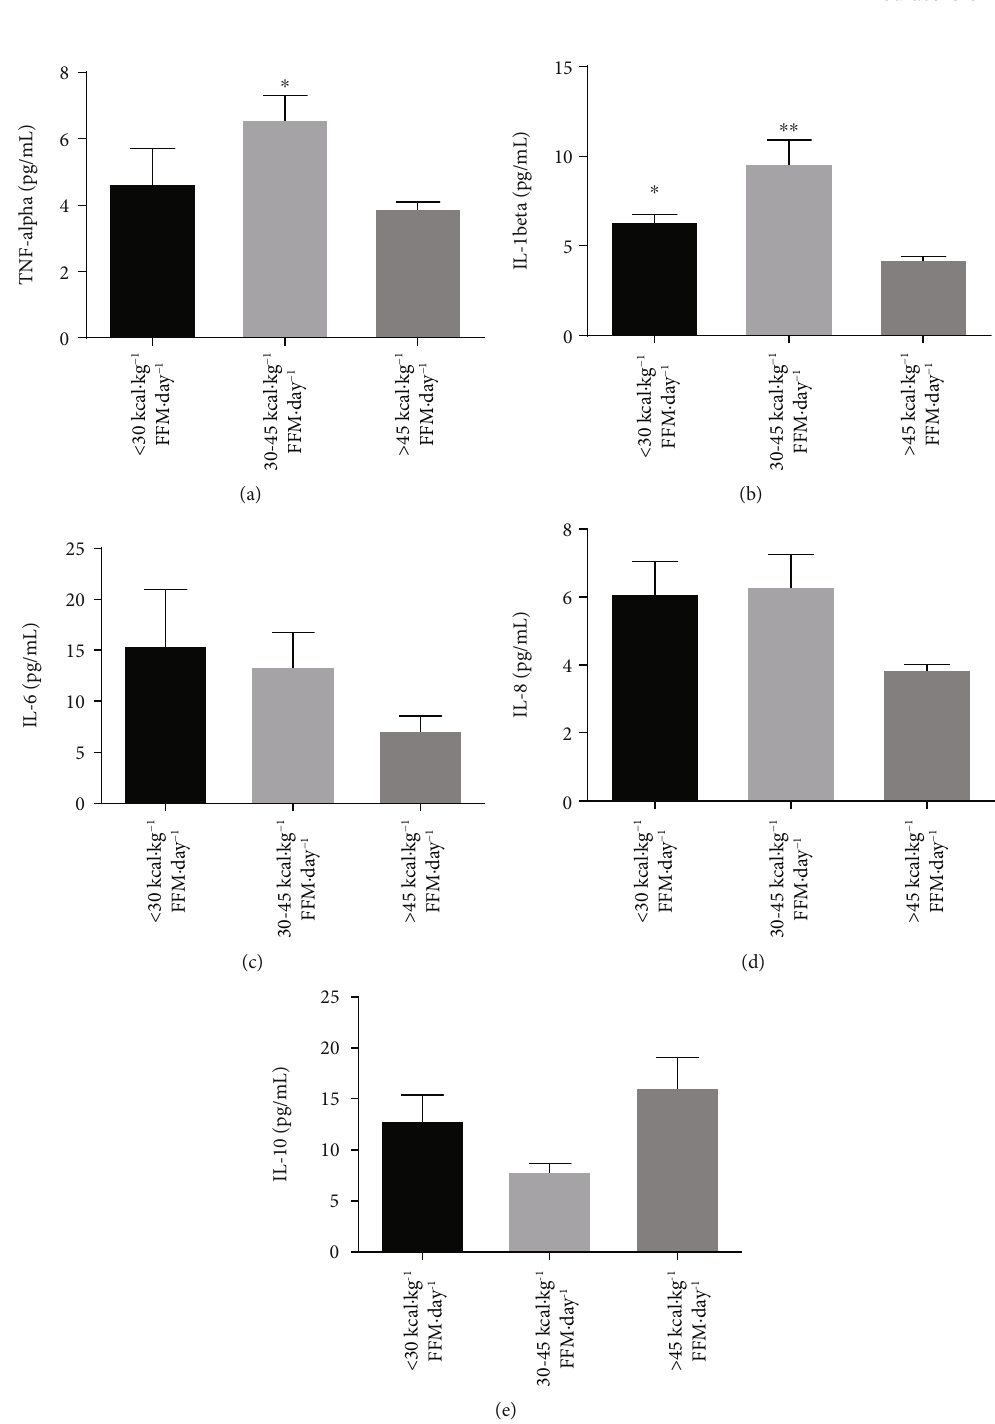
Figure 3: Cytokine release of runners with di ff erent levels of energy intake (EI). TNF- α (a), IL-1 β (b), IL-6 (c), IL-8 (d), and IL-10 (e) plasma concentrations of runners within di ff erent levels of energy intake were evaluated. The runners were divided in 3 groups in accordance with energy intake: relative energy de fi ciency, < 30kcal · kg -1 FFM · day -1 (14 runners); low EI, 30-45kcal · kg -1 FFM · day -1 (14 runners); and adequate EI, > 45kcal · kg -1 FFM · day -1 (16 runners). The values are shown as of mean ± SEM of 8-17 runners. ∗ p < 0 : 05 vs. < 45kcal · kg -1 FFM · day -1 and ∗∗ p < 0 : 0001 vs. < 45kcal · kg -1 FFM · day -1